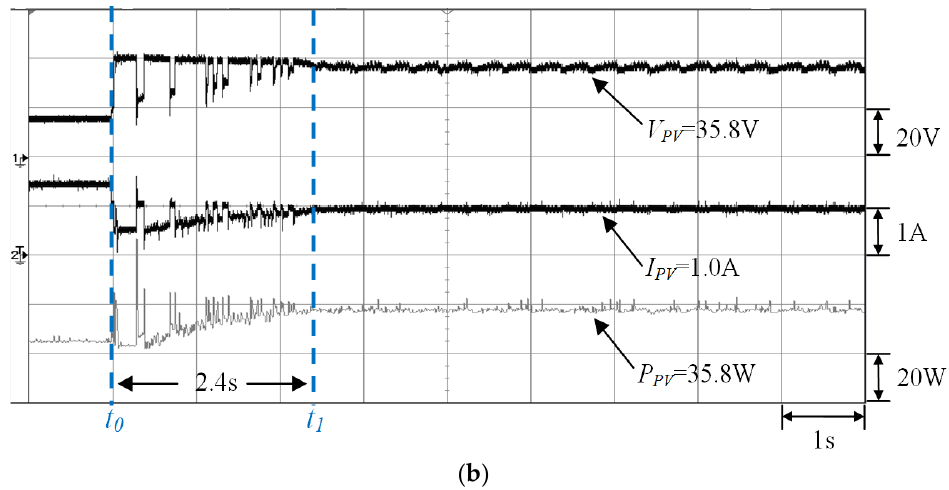
Figure 13. Measurement results of the two-serial and one-parallel module array (0% and 40% shading) by using ( a ) conventional TLBO ( P mp = 35.1 W) and ( b ) the proposed I-TLBO ( P mp = 35.8 W).